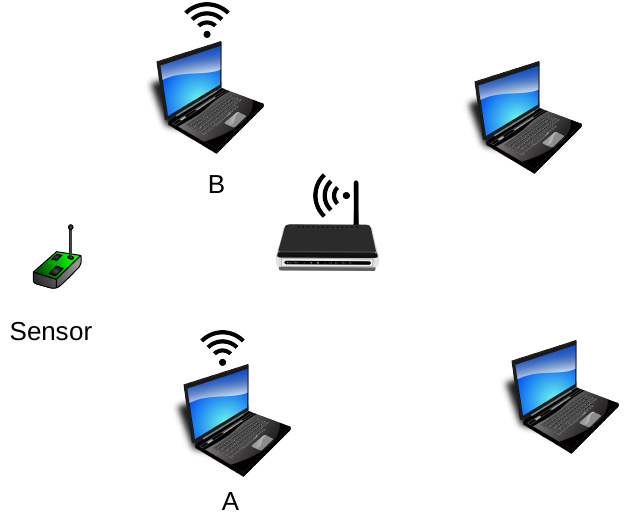
Figure 6. The Sensor-detection method (A and B—stations engaged in covert